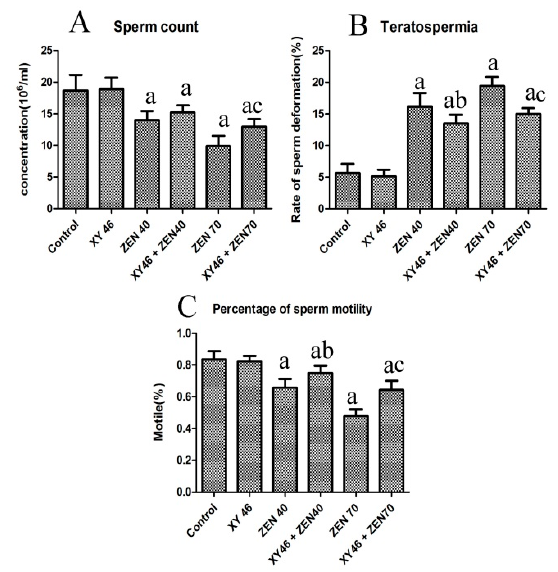
Figure 4. Plots highlighting the quality of the semen derived from the mice, showing: ( A ) mouse sperm concentration, ( B ) mouse sperm deformity rate, and ( C ) sperm motility rate. Key: ‘a’—significantly di ff erent compared to the control group ( p < 0.05), ‘b’—xy46 + ZEA40 is significantly di ff erent from the ZEA40 group ( p < 0.05), and ‘c’—significant di ff erence between xy46 + ZEA70 and ZEA70 groups ( p < 0.05). Seven mice were randomly selected from each group for testing.